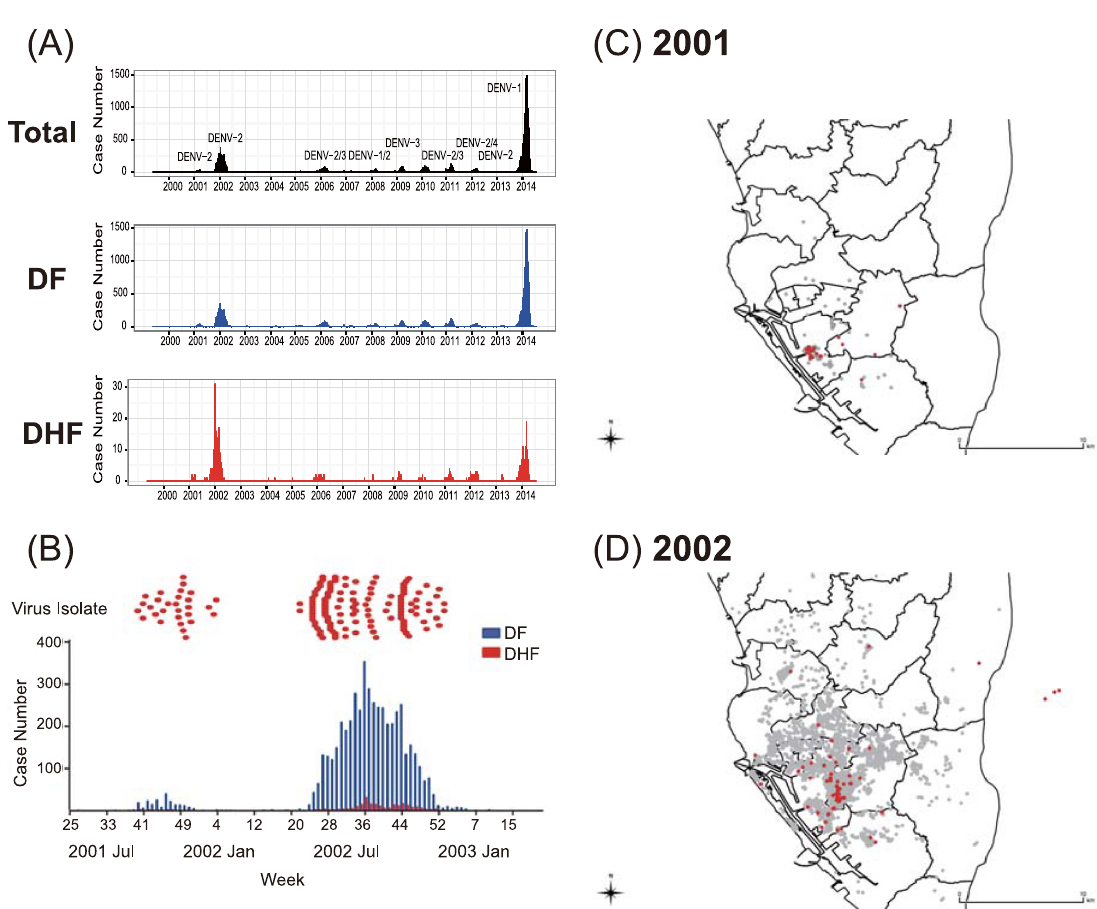
Fig 1. Spatio-temporal distributions of DENV-2 isolated and sequenced from patients in Taiwan, during 2001–2003. (A) The number of laboratory-confirmed, indigenous dengue cases and their major viral serotype found in Kaohsiung city from January 2000 to April 2015. The total numbers of laboratory-confirmed dengue cases, cases diagnosed with dengue fever (DF, blue) or dengue hemorrhagic fever (DHF, red) are shown separately. (B) The isolated DENV-2 strains at each of the respective time points (upper panel), compared to the total numbers of confirmed dengue cases (5305, including 5064 DF and 241 DHF cases) embedded in the epidemic curve for the same period (lower panel). Two consecutive outbreaks occurred in the period from the 35th week, 2001 to the 11th week, 2003: 232 confirmed cases, including 222 DF and 10 DHF cases in 2001; and 5073 confirmed cases, including 4842 DF and 231 DHF cases. (C)(D) Spatial distributions of dengue cases in 2001 (C) and 2002 (D). Red dots represent viral isolates that were investigated in this study; gray plot represents dengue cases reported from